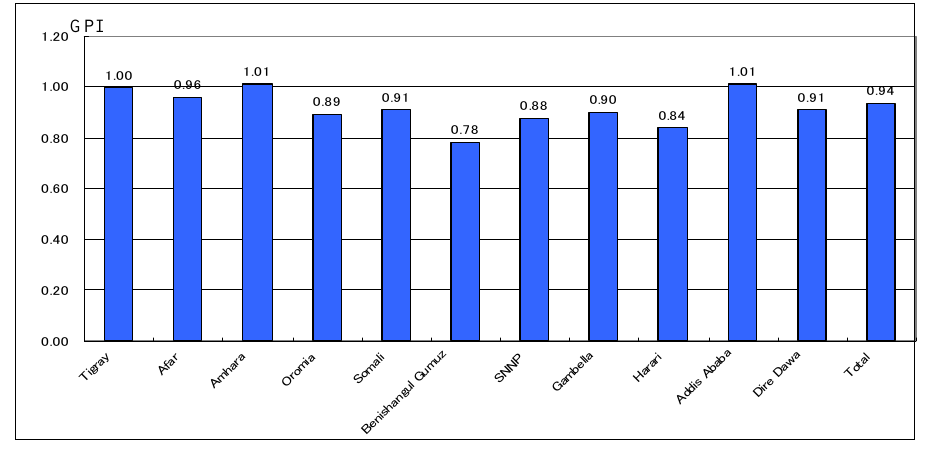
Figure 4-6: Primary Gender Parity Index (GPI) by Region